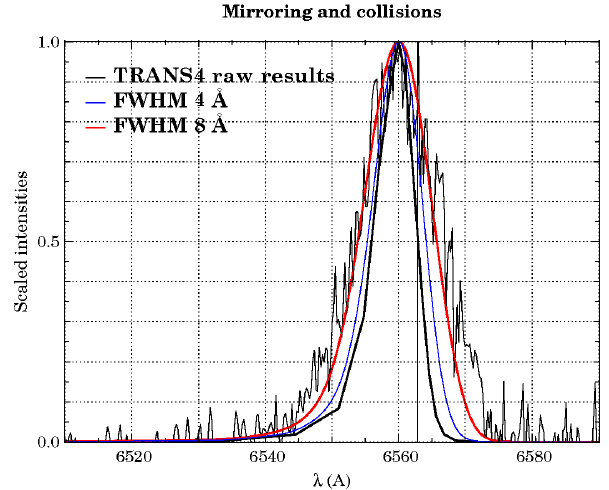
Fig. 6. First out-of-the-box comparison between spectral H α data recorded at Ny- ˚Alesund (discontinuous line) and the model (black line). A triangle function of FWHM=4 ˚A was first chosen for the in- strumental function, which was then convolved with the raw results from the model. The resulting intensity is drawn in blue. When us- ing a triangle function of FWHM=8 ˚A, the model yields the result- ing line intensity drawn in red, which matches the measurements quite